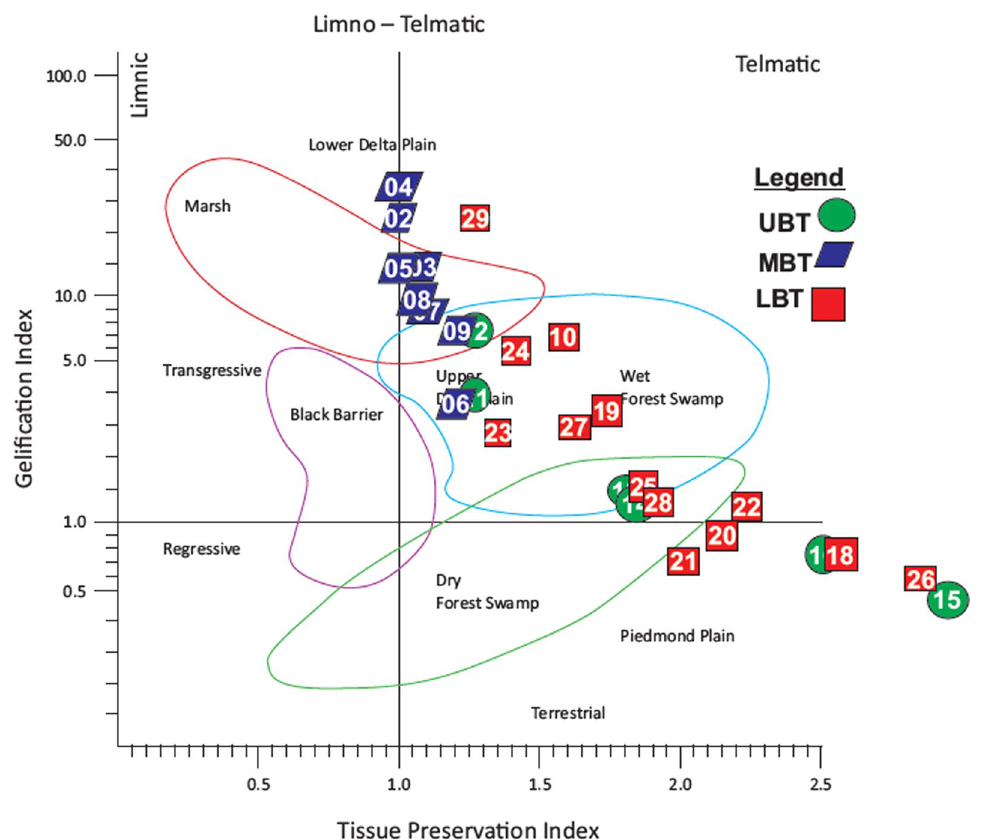
Fig. 8 Coal facies diagram for the coals within the Benue Trough, Nigeria using Eqs. (3) and